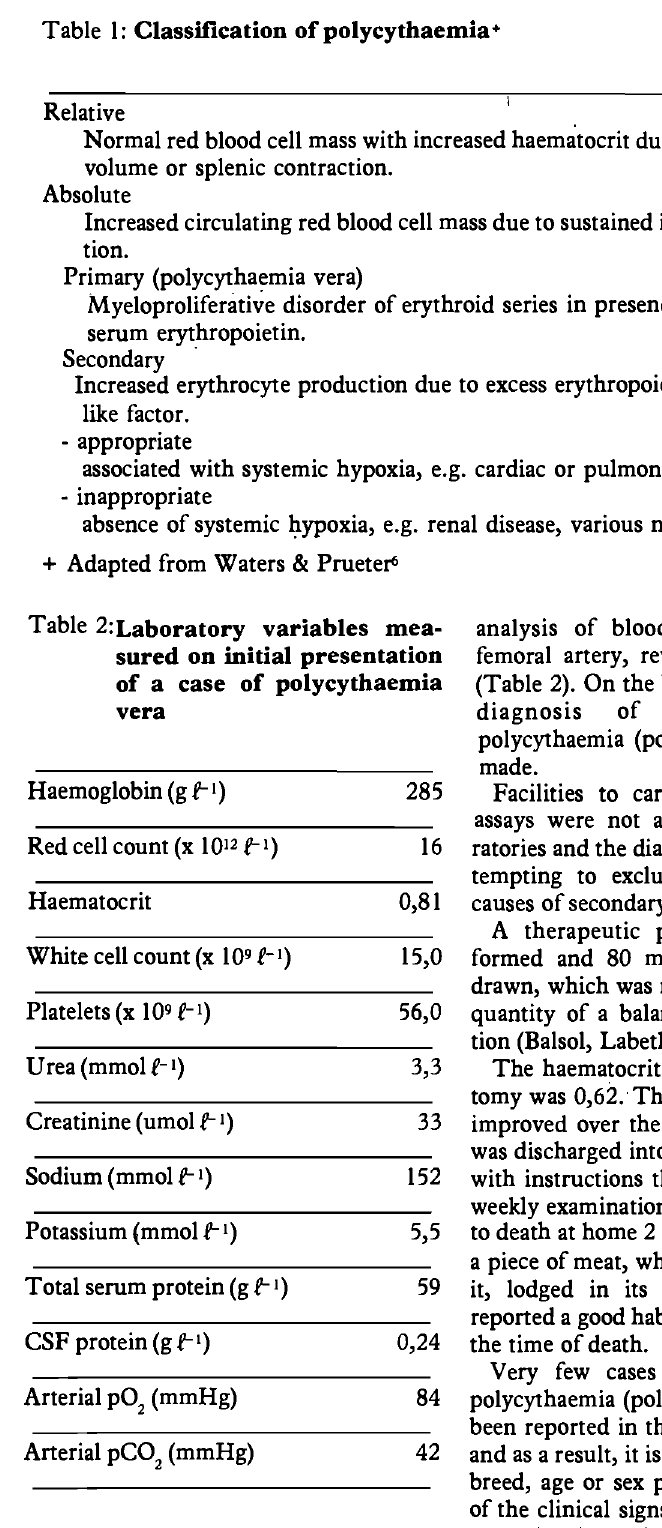
Table I: Classification of polycythaemia +